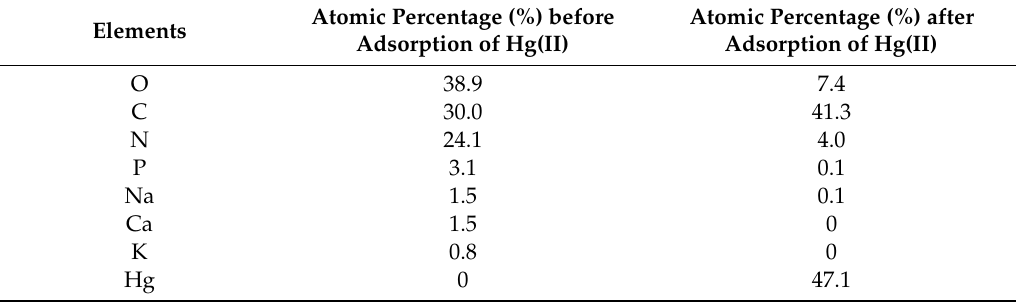
Figure 2. Surface morphology of the biopolymer before (a) and after (b) adsorbing Hg(II). Table 5. The content of elements in the biopolymer before and after adsorption of